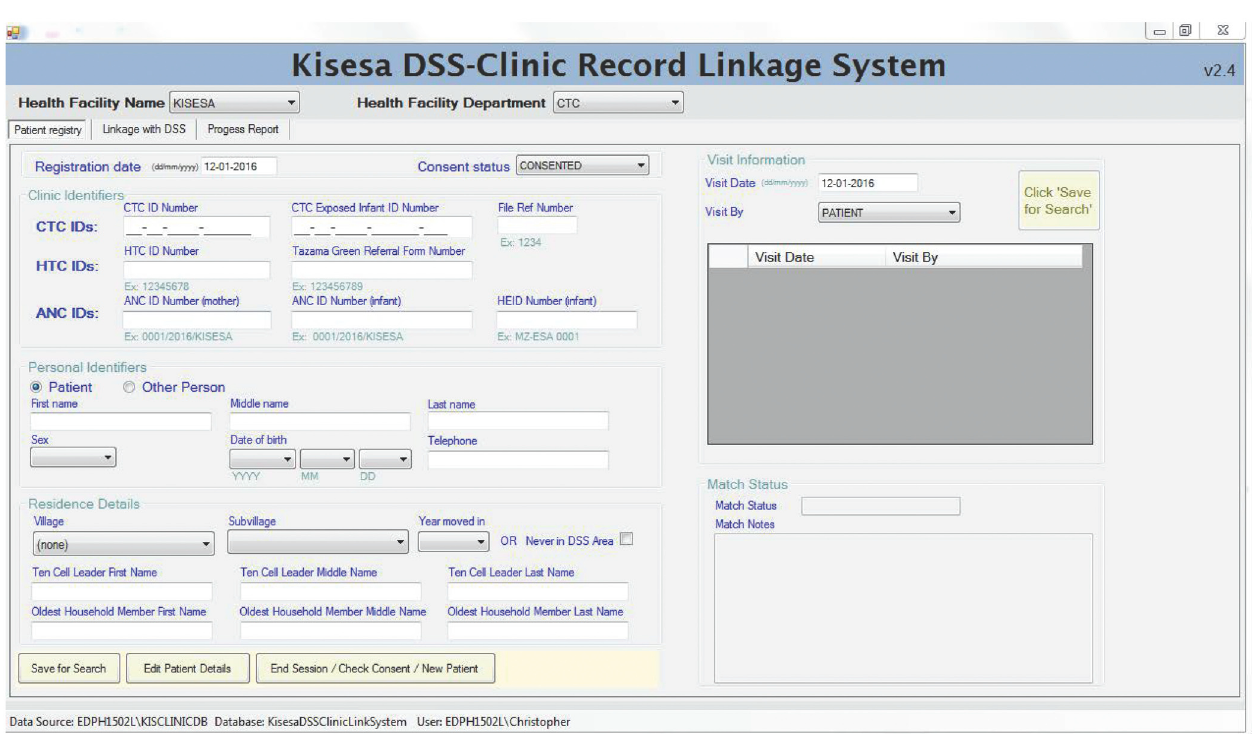
Figure 1. User interface of Point-of-contact Interactive Record Linkage (PIRL)